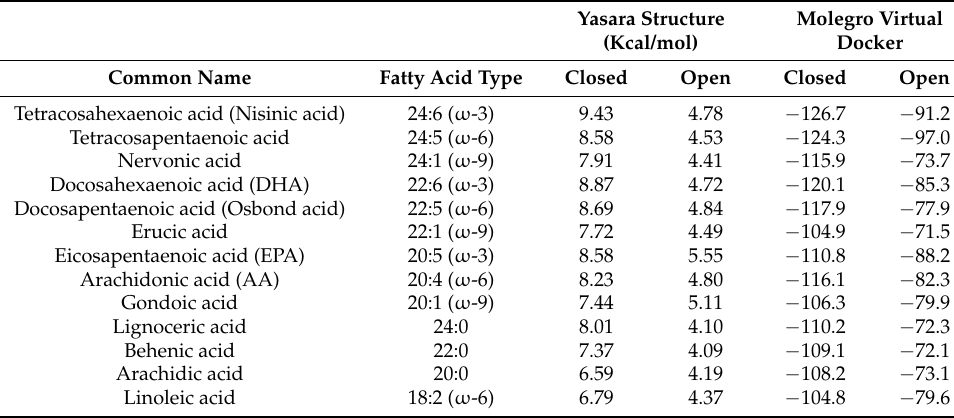
Table 3. Selected results from the docking study carried out on S-protein in its closed and open conformations 1